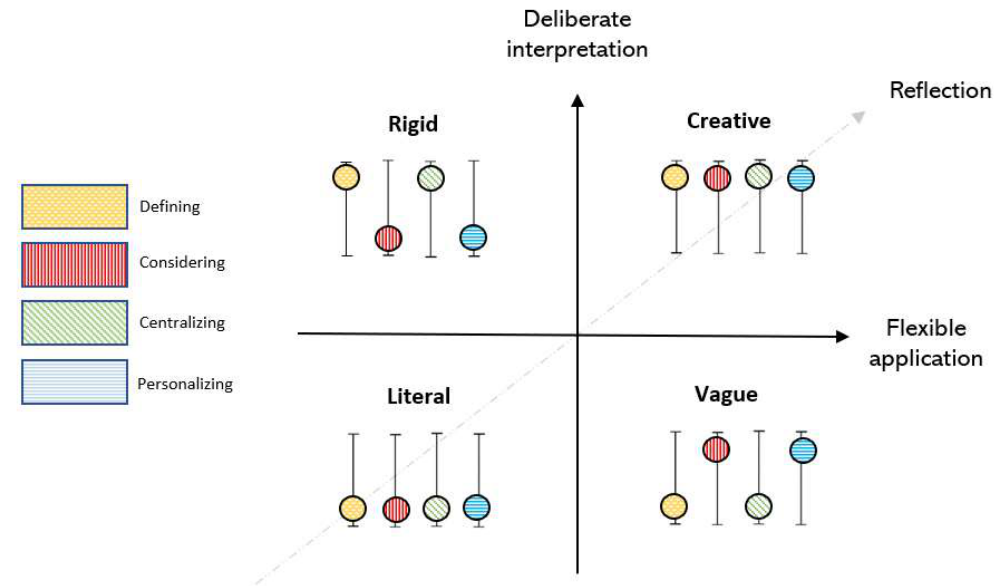
Figure 2. Typologies illustrating different patterns of deliberate and flexible engagement with an mHealth intervention (Life4YOUth).